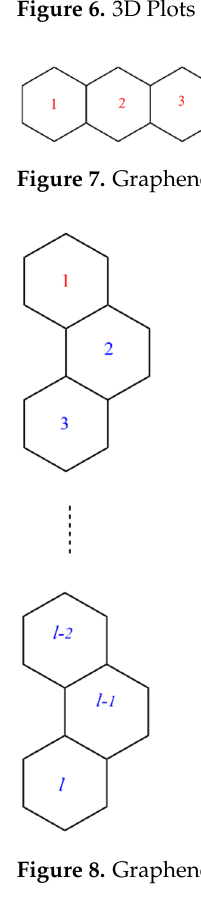
Figure 6. 3 D Plots when ( 𝑙 > 1, 𝑘 > 1) . Figure 6. 3D Plots when ( l > 1, k > 1 ) .